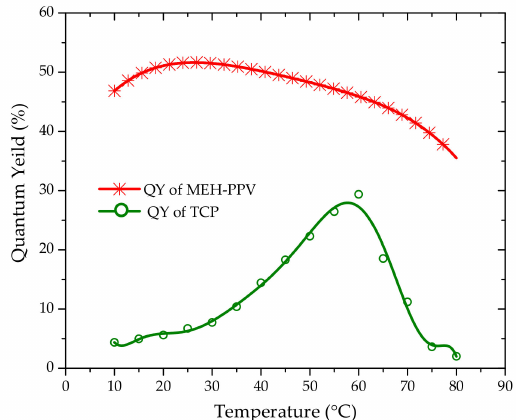
Figure 4. Quantum yield of poly[2-methoxy-5-(2-ethylhexyloxy)-1,4-phenylenevinylene] (MEH-PPV) of concentration 0.5 µ M in benzene (red line with asterisk) and TCP of concentration 10 µ M (green line with circles) at different temperatures. Note that with increasing temperature, the TCP quantum yield increases, but MEH-PPV quantum yield